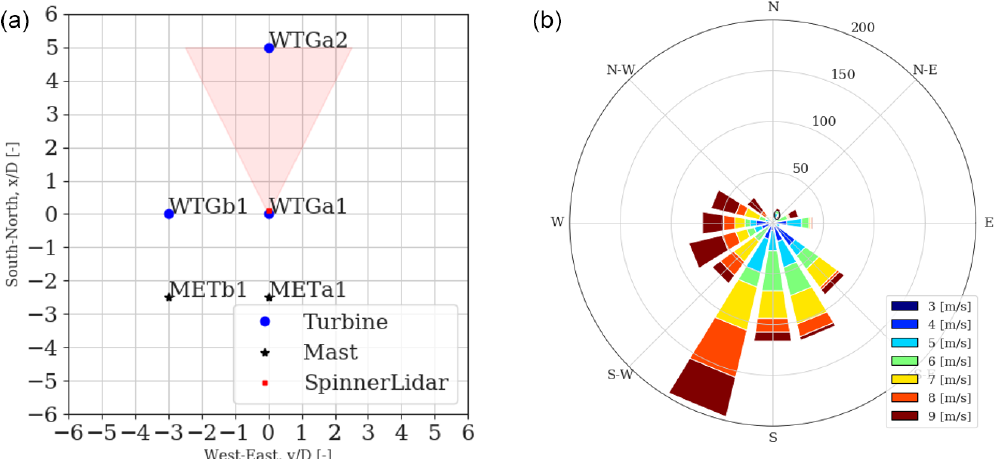
Figure 1. (a) A sketch of the SWiFT layout that includes locations of the main devices (i.e. wind turbines, masts, and the SpinnerLidar). The shaded red area indicates that the SpinnerLidar scans in the wake of WTGa1 assuming winds from the south. The distances are normalized with the rotor diameter D . (b) The wind rose at the site derived from the 32m sonic observations collected on METa1 during the campaign.